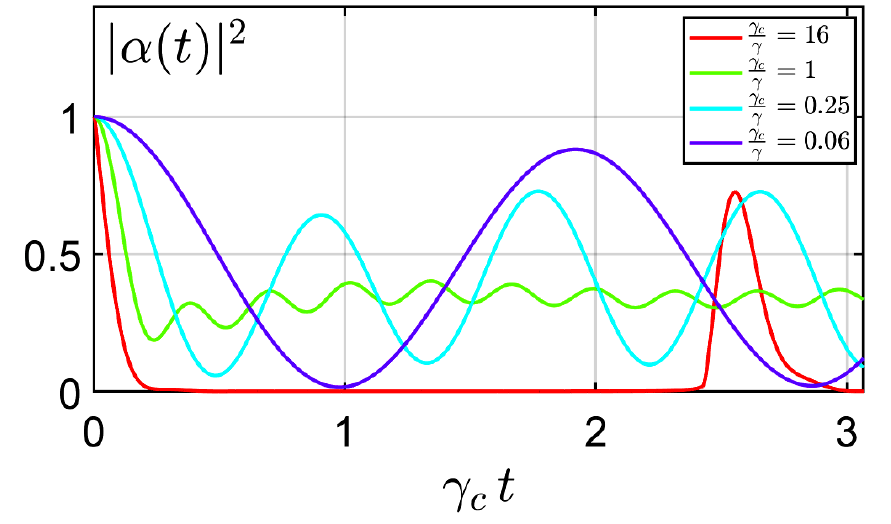
Figure 3. Survival probability in function of time respecting the scaling constraint ρ constant but varying the number of modes N .